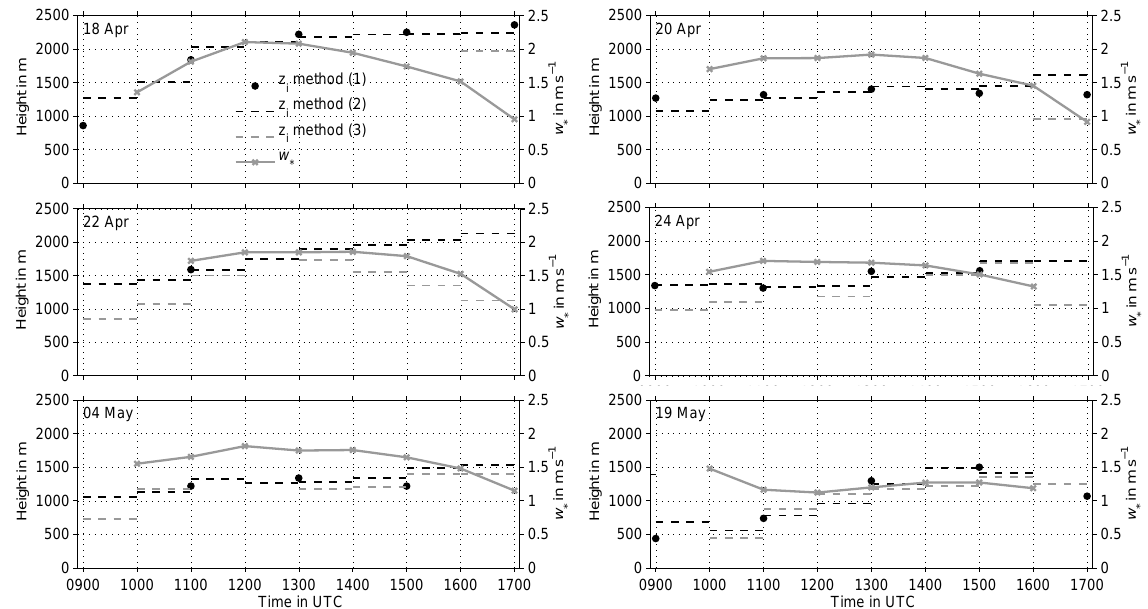
Figure 5. CBL heights derived from radiosoundings (maximum temperature gradient = inversion; method 1), from lidar backscatter data (WTX; method 2) as well as from a variance threshold (method 3) for all considered cloud-free days; additionally, the convective velocity scale w ∗ (determined using weighted-averaged values of sensible heat flux) is given.